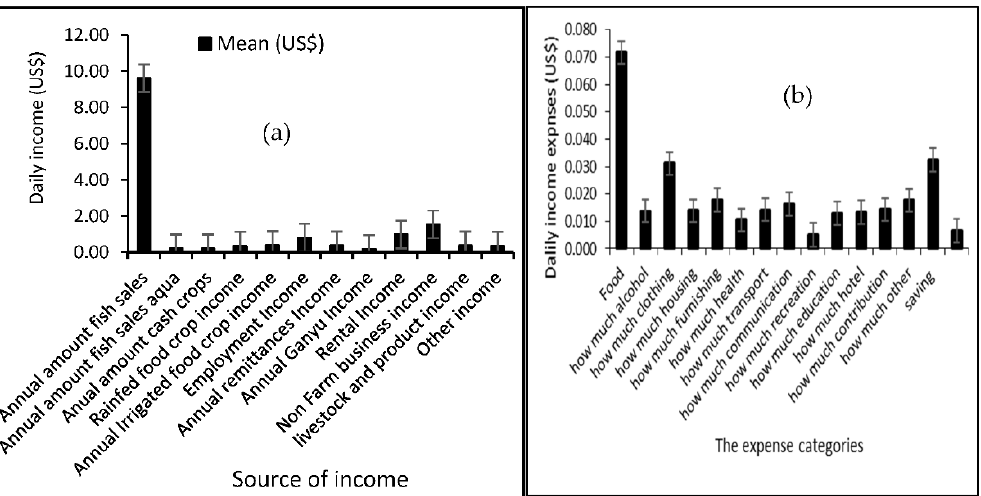
Figure 10- Driving forces of Lake Malombe ecosystem dynamics. Figure 10. Driving forces of Lake Malombe ecosystem dynamics. ( a ) source of income ( b ) the expense